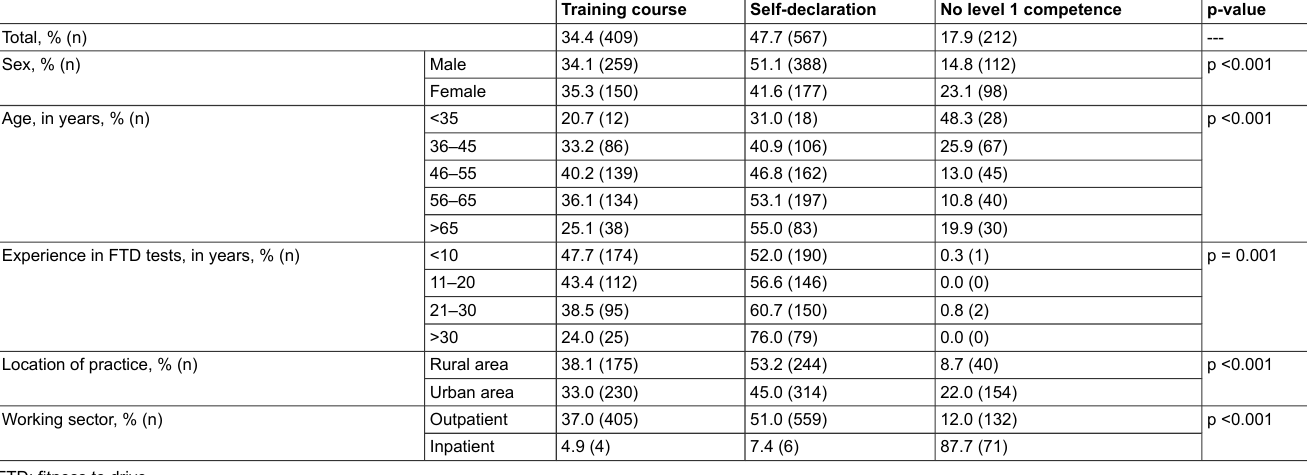
Table 2: How did the general practitioners acquire their level 1